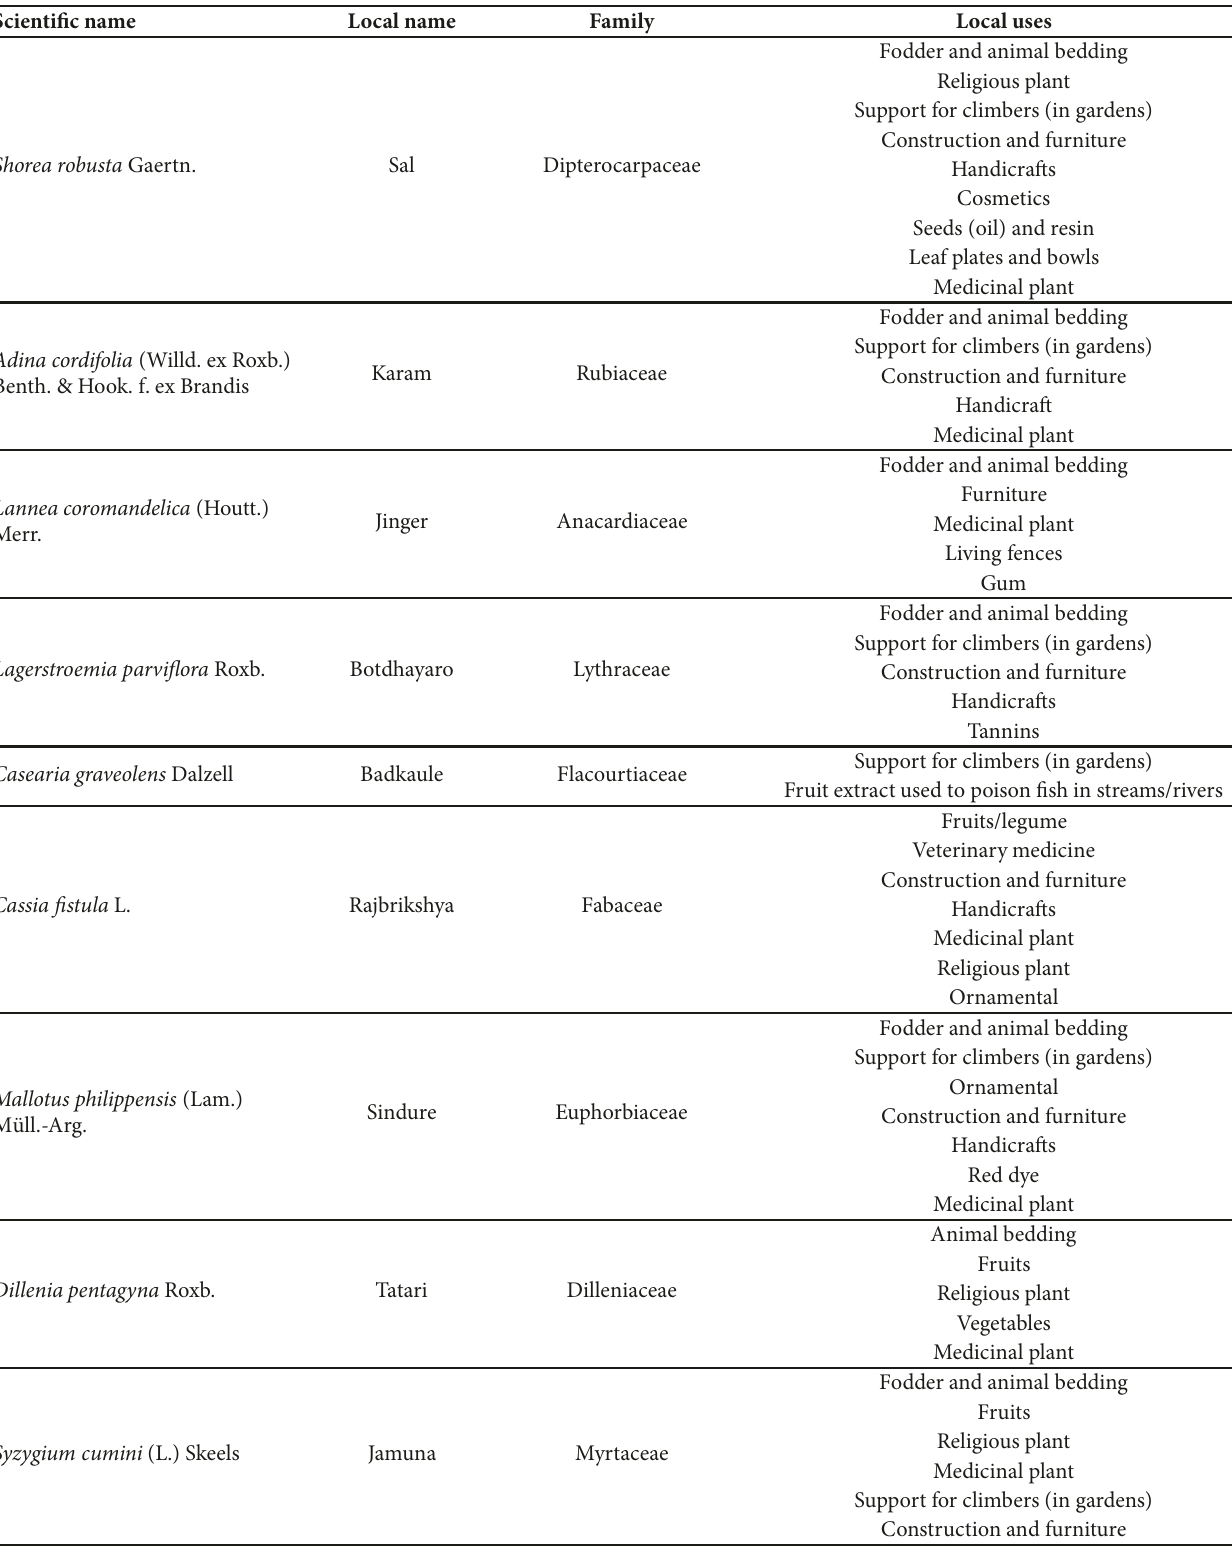
Table 1: List of predominant woody species (species with Importance Value Index > 10) found in the sampling sites and their local uses (all species are used as